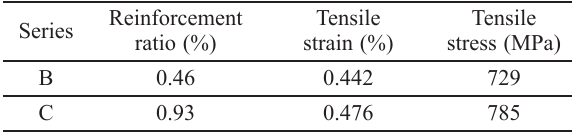
Table 6. Average values of tensile strain and stress in CFRP reinforcement at failure Reinforcement Tensile Tensile Series ratio (%) strain (%) stress (MPa) B 0.46 0.442 729 C 0.93 0.476